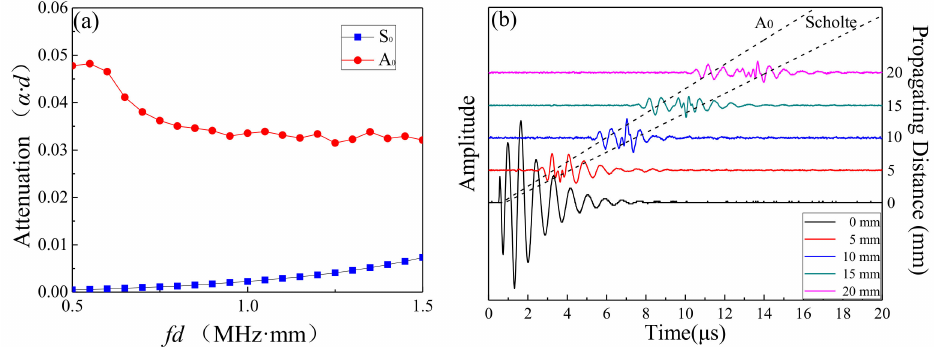
Figure 7. ( a ) Normalized attenuation curves for A 0 and S 0 modes in the underwater aluminum plate; ( b ) Time domain signal at different positions using the top generation configuration.